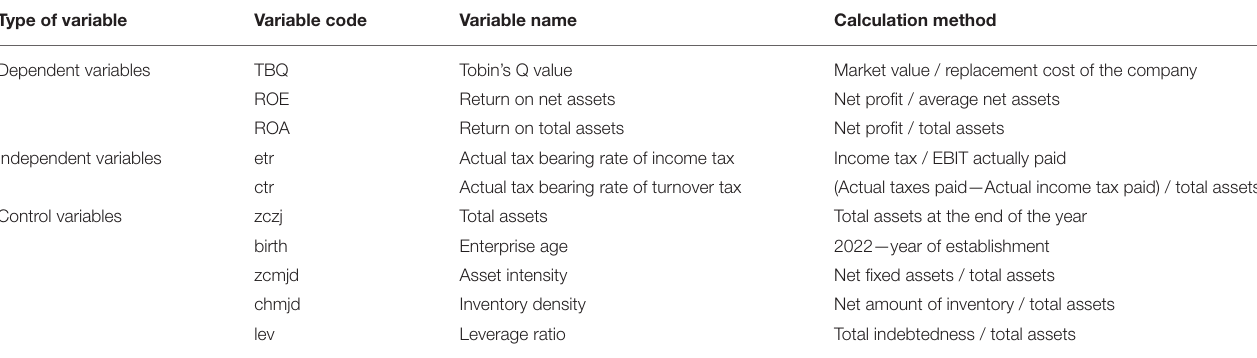
TABLE 2 | Variables